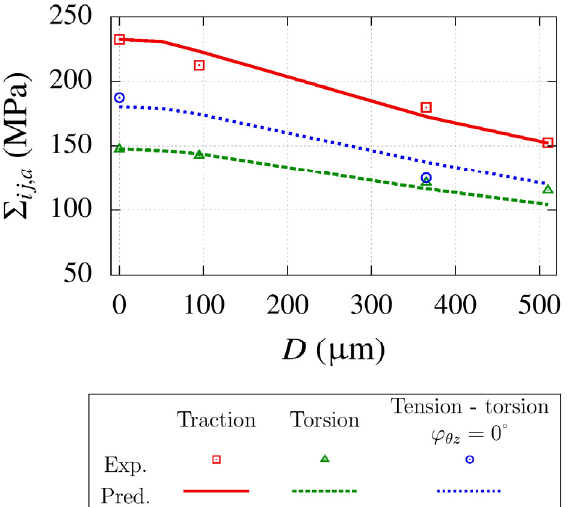
Figure 5: Predictions of the probabilistic model in a Kitagawa type diagram. Comparison with the multiaxial fatigue experimental data for the 316L steel.